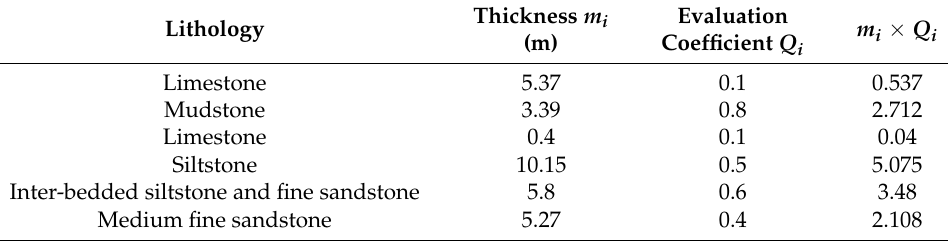
Table 1. Calculated values of the comprehensive evaluation coefficient P from the G37